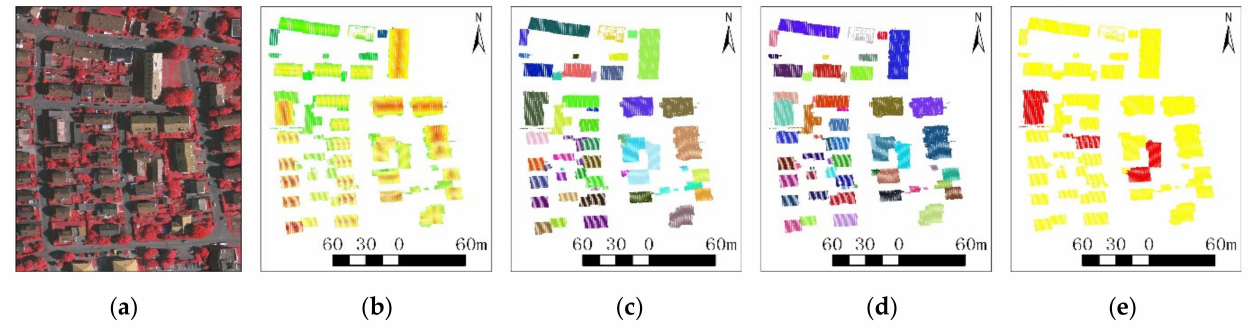
Figure 10. Building instance segmentation result of dataset 3: ( a ) Aerial image corresponding to input data; ( b ) the building point clouds; ( c ) the result of UBIS method; ( d ) the ground truth; ( e ) the main differences between the UBIS method result and the ground truth.